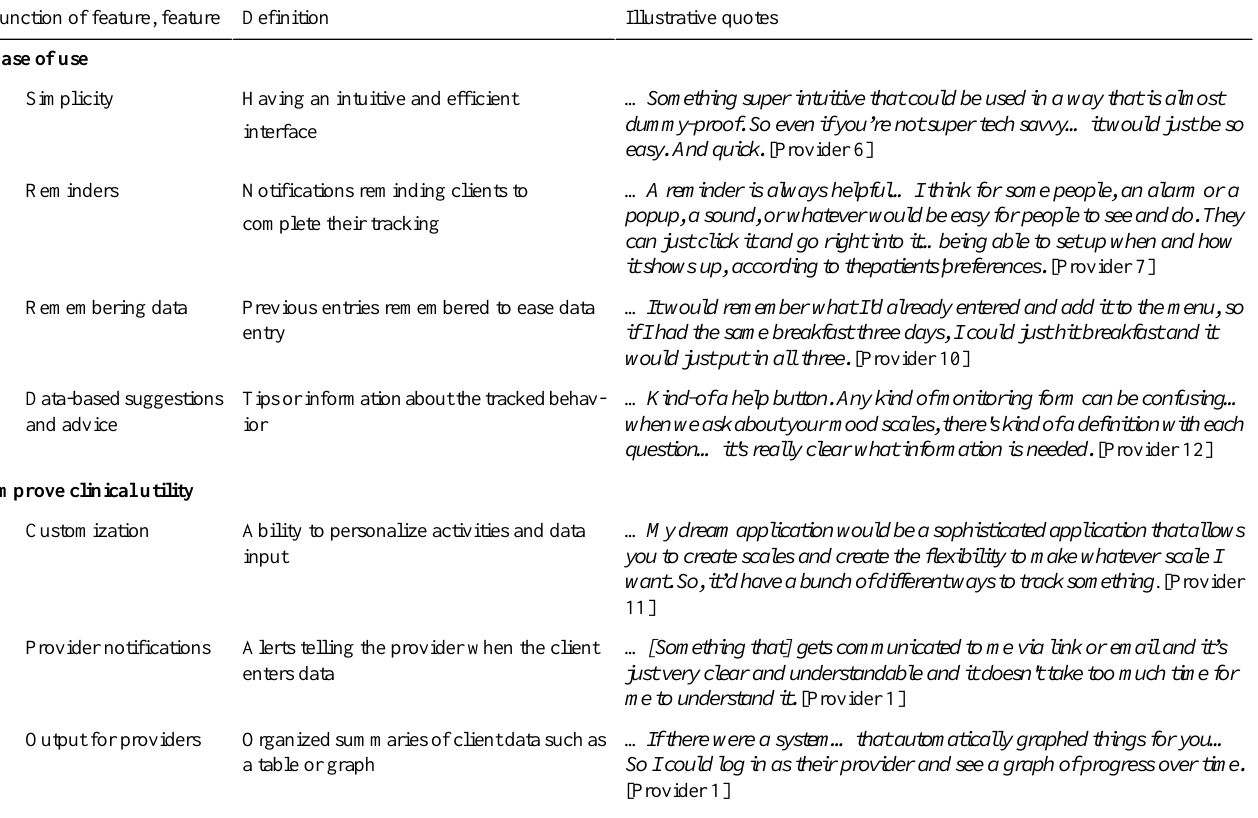
Illustrative quotesDefinitionFunction of feature,